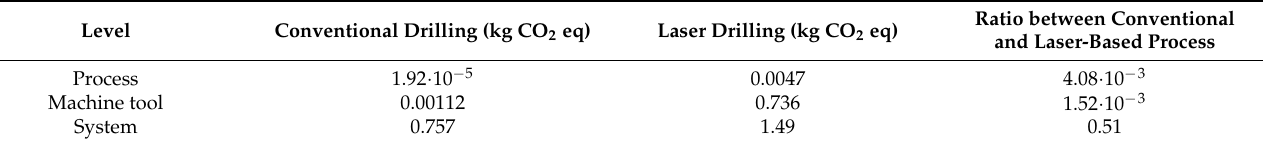
Table 7. Comparison of carbon footprint per level between conventional and laser drilling.